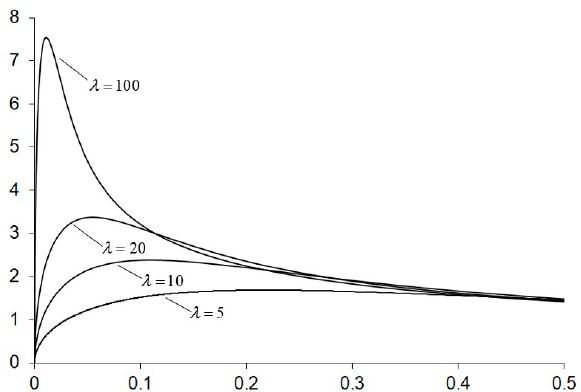
Figure 1. Distribution of normalized stresses Ξ y 0 ( r , λ ) on the normalized distance from the crack tip r , ( θ = 0 ) and normalizing scale factor λ .